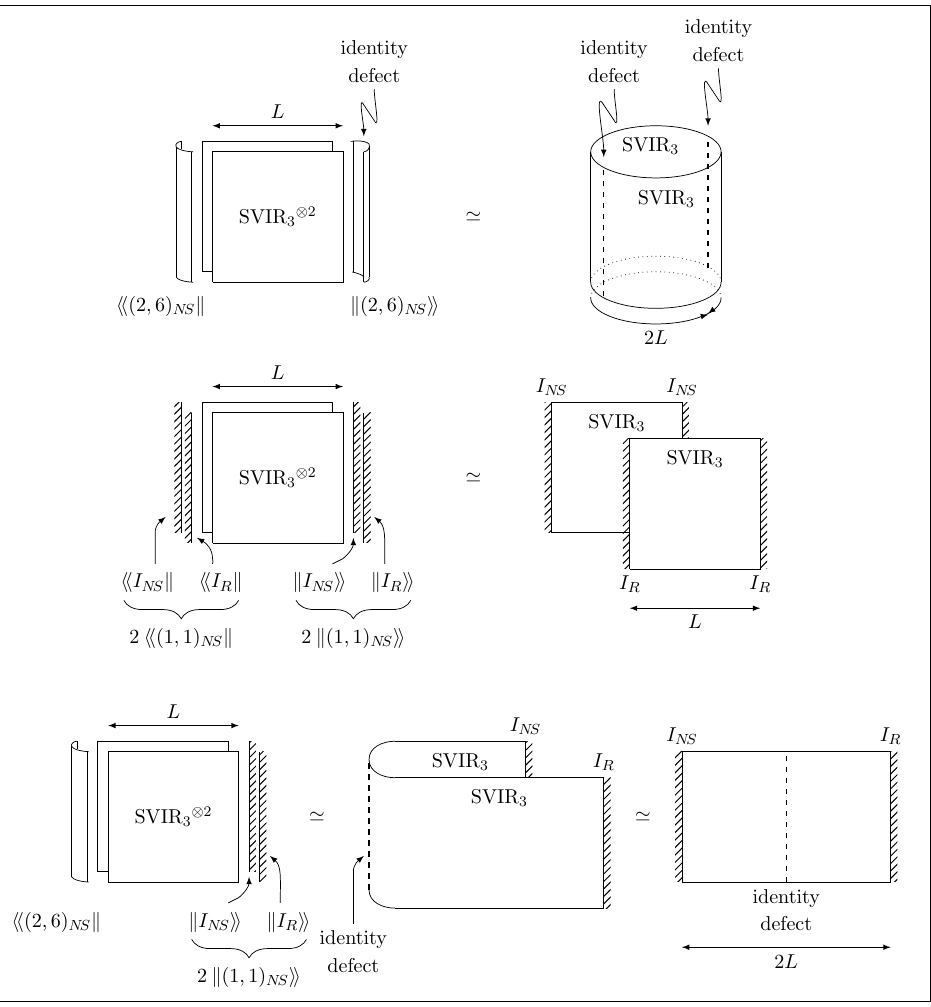
Figure 5 . Di(cid:11)erent boundary conditions on SVIR 3 (cid:10) 2 result in di(cid:11)erent geometrical set-ups for SVIR 3